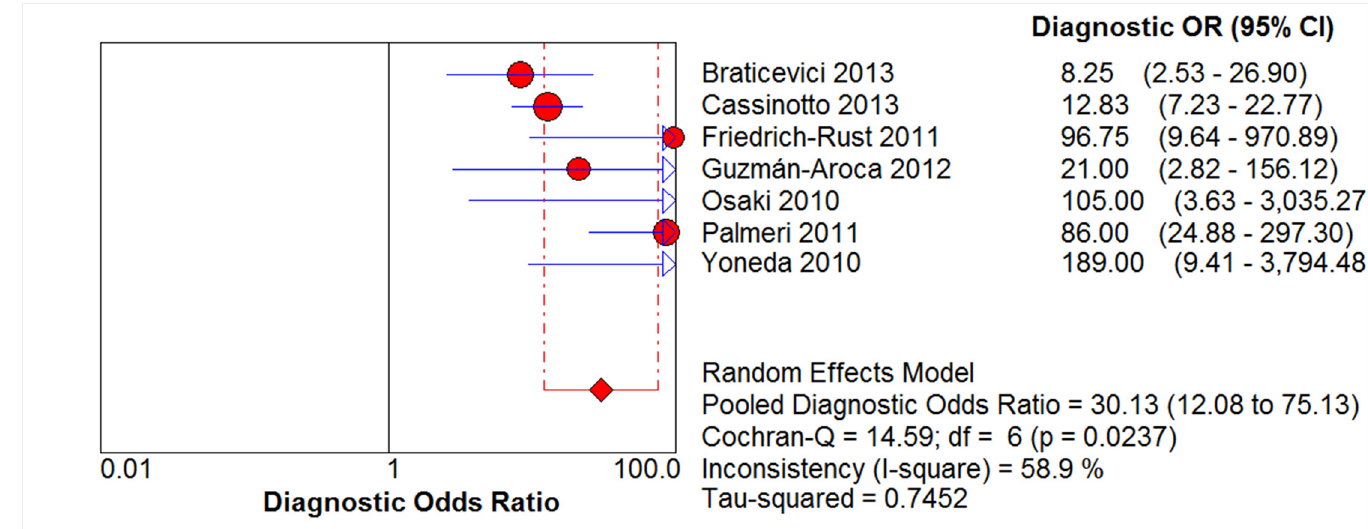
Fig 3. Forest Plot of Diagnostic Odds Ratio. The red circles and the horizontal blue lines represent the point estimates and 95% confidence interval (CIs) of the included studies, respectively. The weight of each study is depicted by the size of its respective circle. The center of the red diamond represents the pooled estimate, and the red dotted lines represent the 95% CI of the pooled